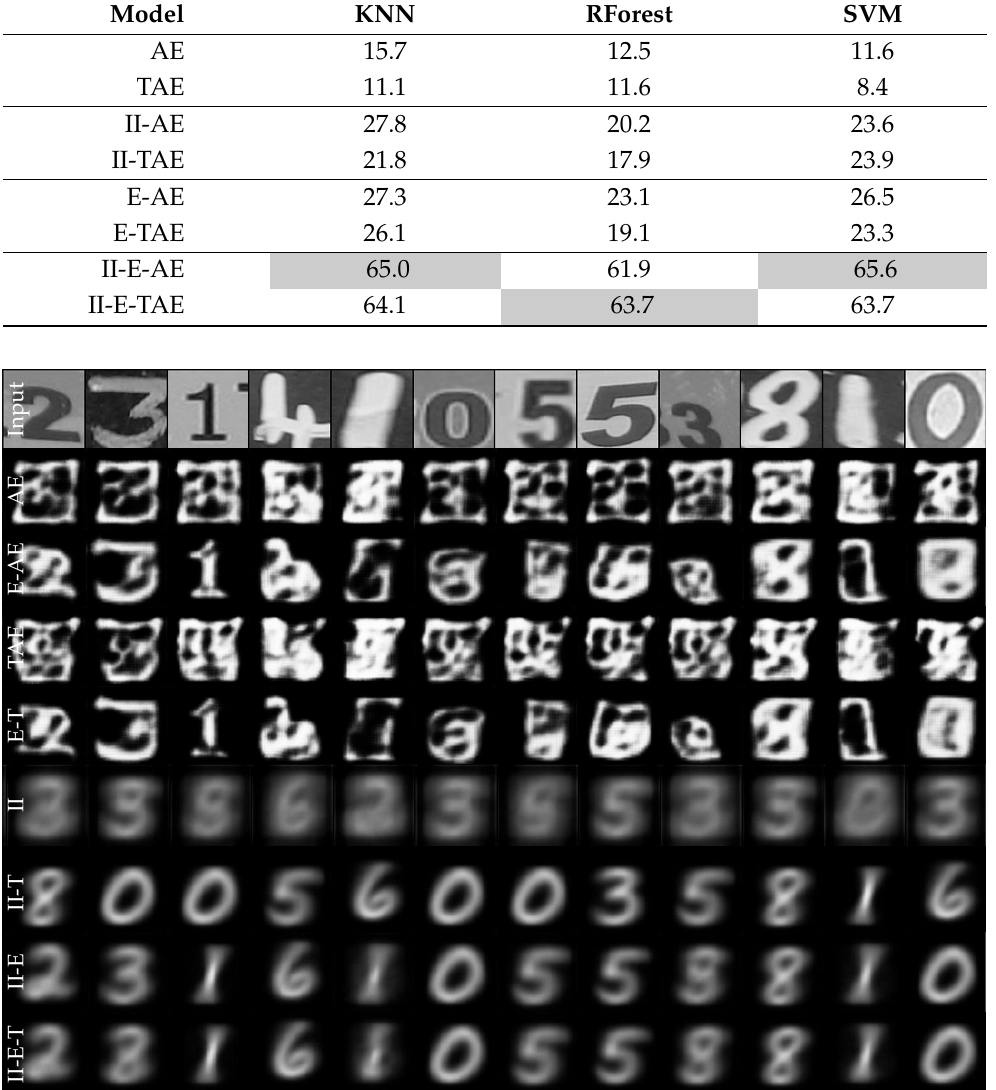
Figure 12. Reconstruction of real digits when trained on MNIST. We either used the triplet loss (T or TAE), the second variation of the PIRL (II) and/or the extractor (E) or just the vanilla reconstruction loss (AE). The II-PIRL provides the best class preserving